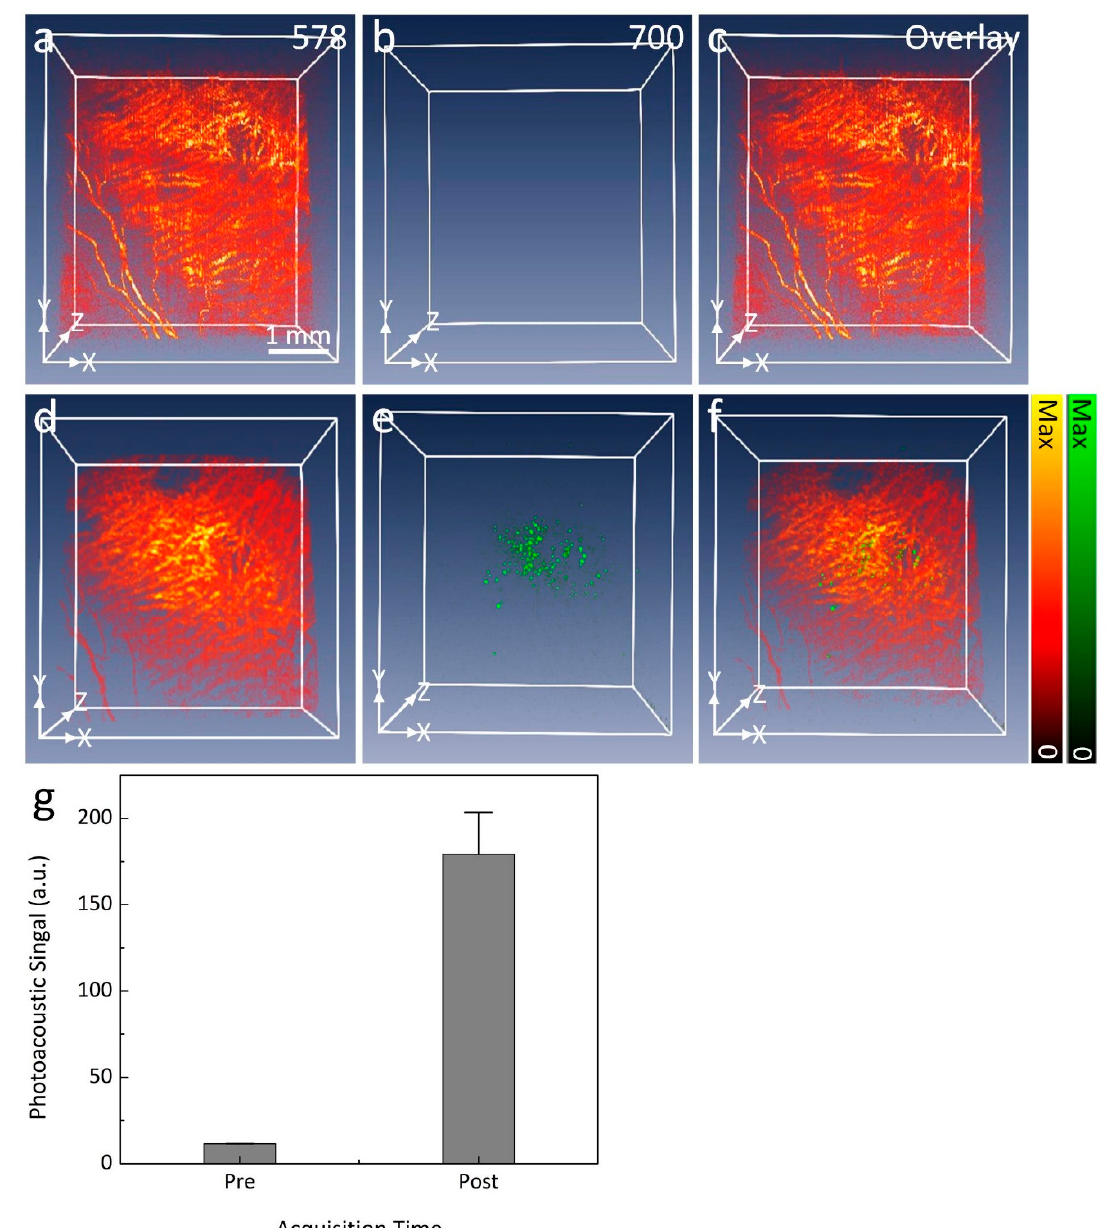
Figure 5. In vivo PAM visualization of CVO. ( a – c ) Three-dimensional PAM images of CVO acquired at two different wavelengths (578 and 700 nm) before the intravenous injection of ICG dye. No PAM signal was observed on the PAM images obtained at 700 nm. ( d – f ) Three-dimensional PAM images of CVO obtained 15 min after injection. The location of CVO and scars were observed and illustrate high image contrast at the wavelength of 700 nm in comparison with before injection. Overlay 3D image ( f ) demonstrates the evaluation of CVO when compared to the surrounding choroidal microvasculature. ( g ) A significant increase in photoacoustic signal at 700 nm after intravenous administration of ICG can be seen.